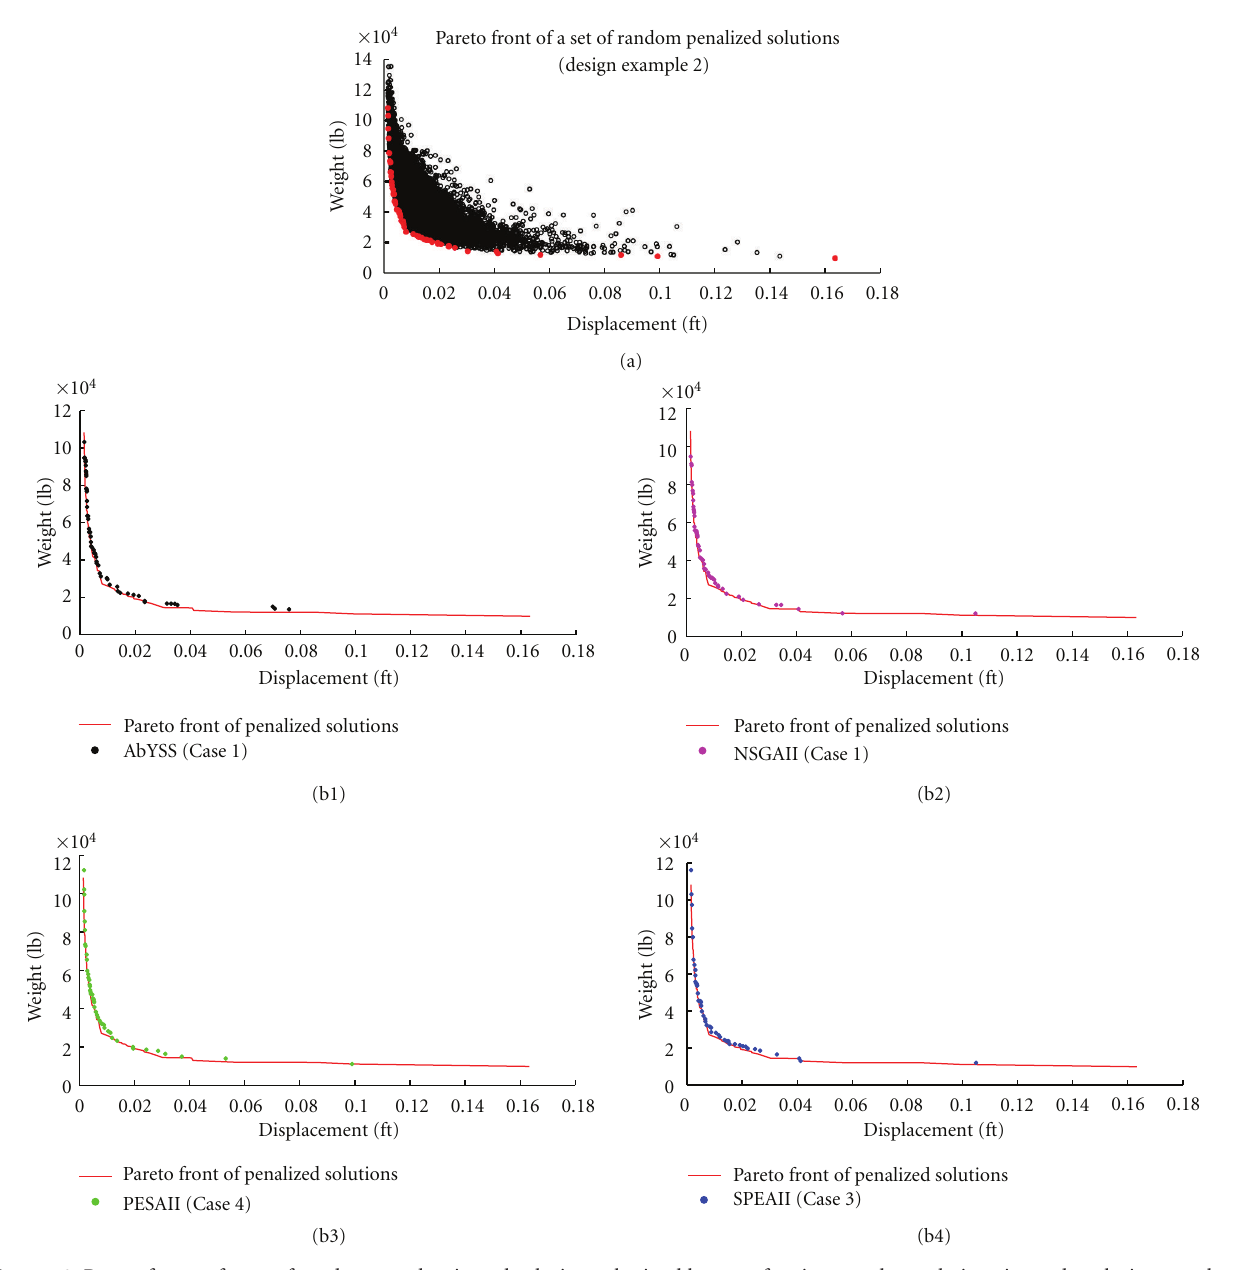
Figure 8: Pareto fronts of a set of random nondominated solutions obtained by use of an increased population size and evolution number (a) and AbYSS, NSGAII, PESAII, and SPEAII (b1)–(b4).